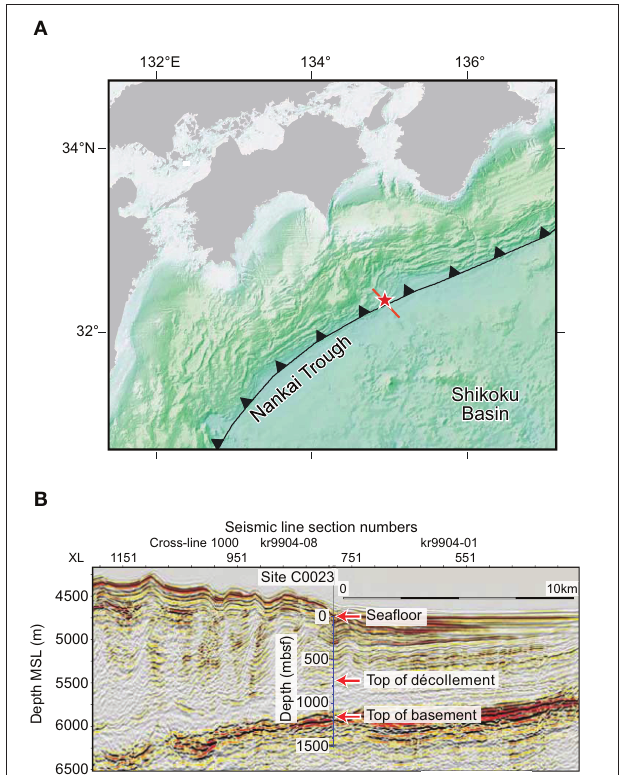
FIGURE 2 | (A) Regional map around IODP Site C0023 (Heuer et al., 2017b). The star symbol and red line show the locations of the site and seismic line section of (B) , respectively. (B) A seismic section at the toe portion of the Nankai Trough off Muroto ( Heuer et al., 2017b). The arrows indicate the horizons of the sea floor, the top of the décollement zone, and the top of the oceanic basement.